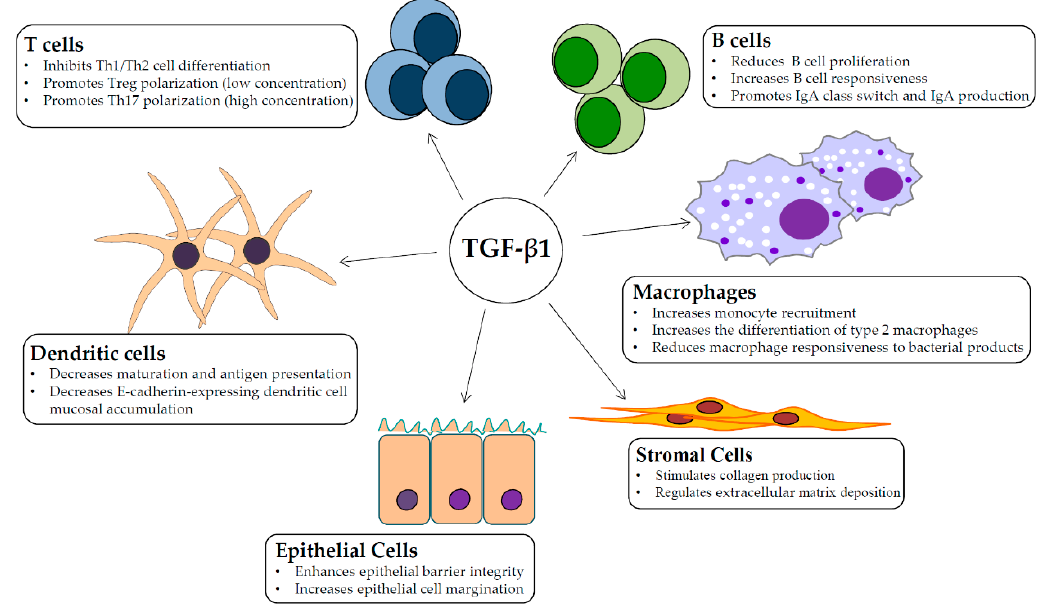
Figure 1. Schematic view of the main cell targets and biological function of transforming growth factor (TGF)- β 1 in the gut.